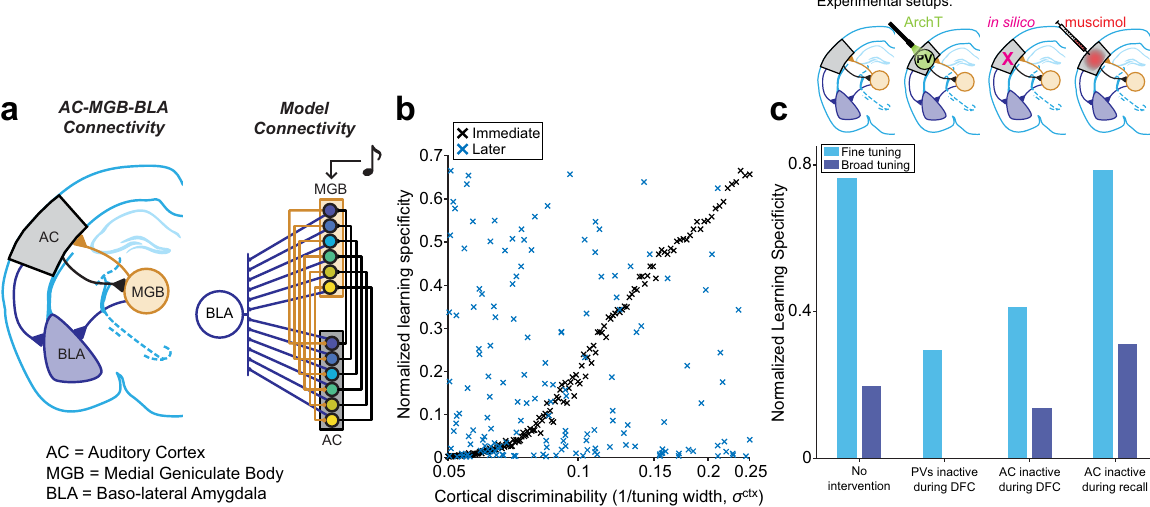
Fig. 7 A learning model reconciles present and past fi ndings. a (left) Connectivity between auditory cortex (AC, gray), medial geniculate body (MGB, orange), and basolateral amygdala (BLA, blue). (Right) Model connectivity. MGB receives auditory input and provides input to AC (orange lines), and both MGB and AC provide inputs to BLA (blue lines). AC feeds back to MGB (black lines). Colored circles represent neurons tuned to different, overlapping frequency ranges. b Normalized learning speci fi city output from the model with varying levels of AC discriminability, achieved by changing the frequency tuning overlap between the neurons in the AC population, σ ctx . Learning speci fi city was measured at two time points, immediately after DFC (black) and 10 4 time-steps later (blue). c Normalized learning speci fi city at two AC discriminability levels; fi ne (light blue) and broad (dark blue) tuning. Results are shown for learning speci fi city with no interventions, when inhibition is reduced in AC during DFC (analog of when ArchT-transfected PV interneurons in AC are inactivated by optogenetics during DFC), when AC is inactivated during DFC (in the model), and when AC is inactivated during memory recall (analog of an injection of muscimol during memory recall; PV = parvalbumin-positive interneurons, ArchT = Archaerhodopsin-T). Source data are provided as a Source data fi